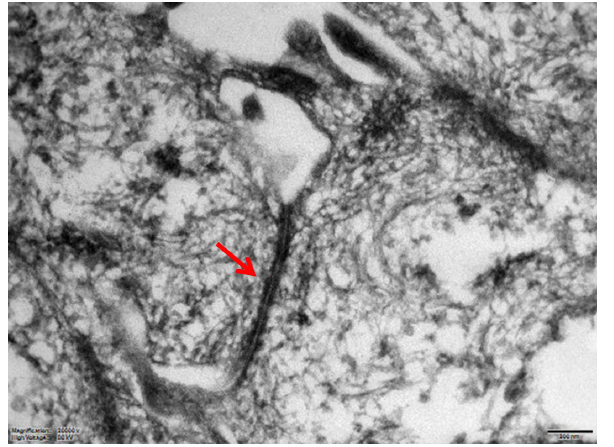
Figure 5. Electron microscopic image of a long desmosome (ar- row) between mesothelial cells (scale bar: